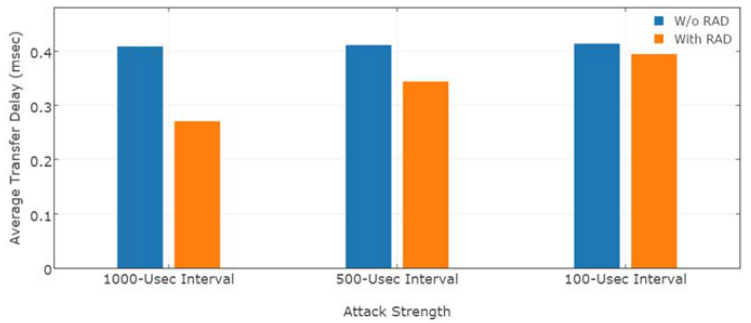
Figure 10. Average transfer delay vs. attack strength.